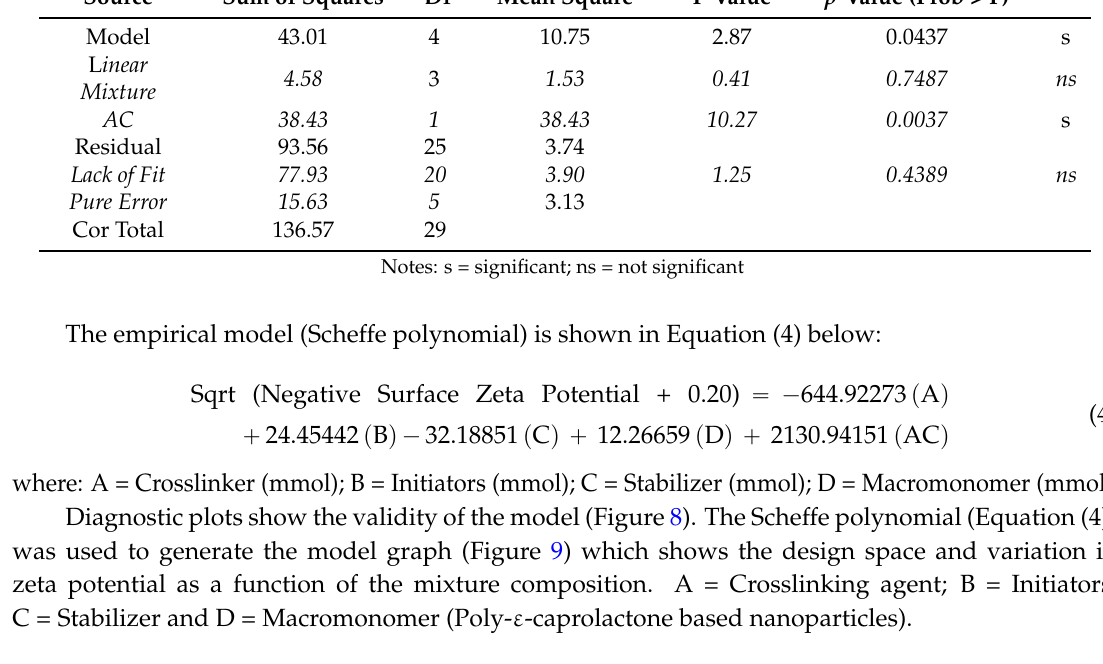
Table 6. Analysis of variance table for zeta potential (Poly- ε -caprolactone-based nanoparticles. Source